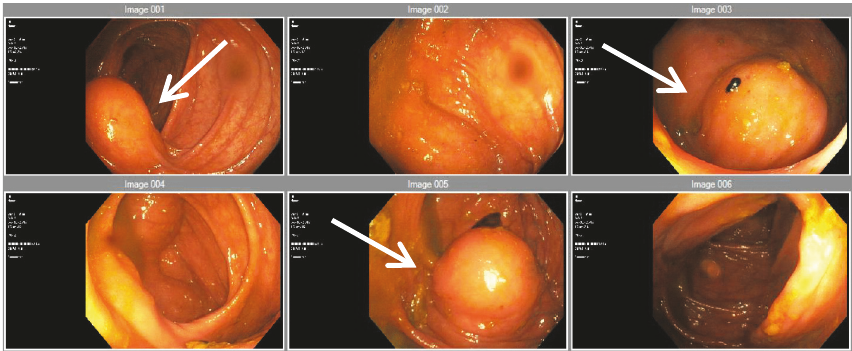
Figure 2: Extraluminal compression caused by the mucocele seen during the colonoscopy (white